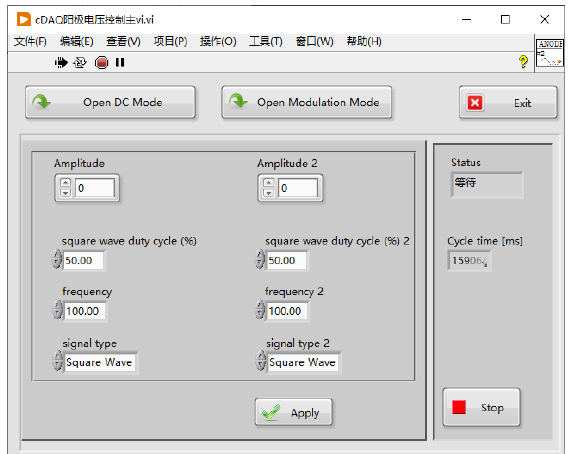
Fig. 6. The host computer control interface (modulation mode) of the ASIPP anode power supply.